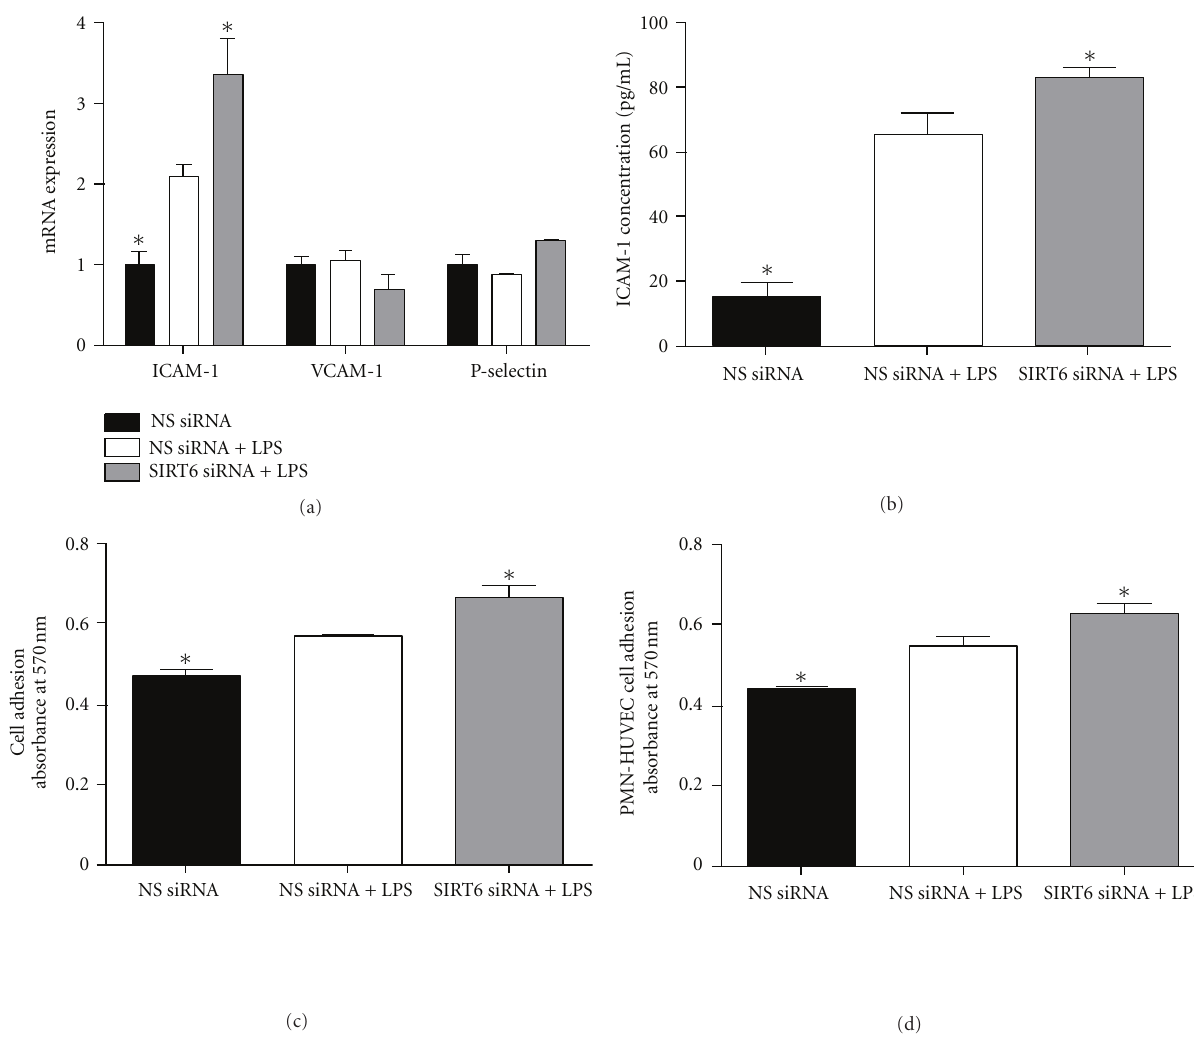
Figure 6: E ff ect of SIRT6 knockdown on cell adhesion. HUVECs were transfected with 50nM SIRT6 or NS siRNA for 72h followed by 10 μ g/mL LPS for 24h ( n = 6). (a) The gene expression of the adhesion molecules VCAM-1, ICAM-1, and P-selectin was quantified by qRT-PCR. (b) ICAM-1 concentration in the conditioned media was assayed using ELISA. (c) Transfected HUVECs were plated onto gelatin- coated 96-well plates for 1.5 h, and cell adhesion assays were performed using MTT. Extracted dye was quantified by absorbance at 570 nm. Each bar represents the mean ± SEM. ∗ P < 0 . 05 versus NS siRNA + LPS. (d) PMN cells were added to each well and were incubated at 37 ◦ C for 60min. The number of adhered PMNs was evaluated by a colorimetric assay using MTT assay and quantification by absorbance at 570nm. Each bar represents the mean ± SEM. ∗ P < 0 . 05 versus NS siRNA +